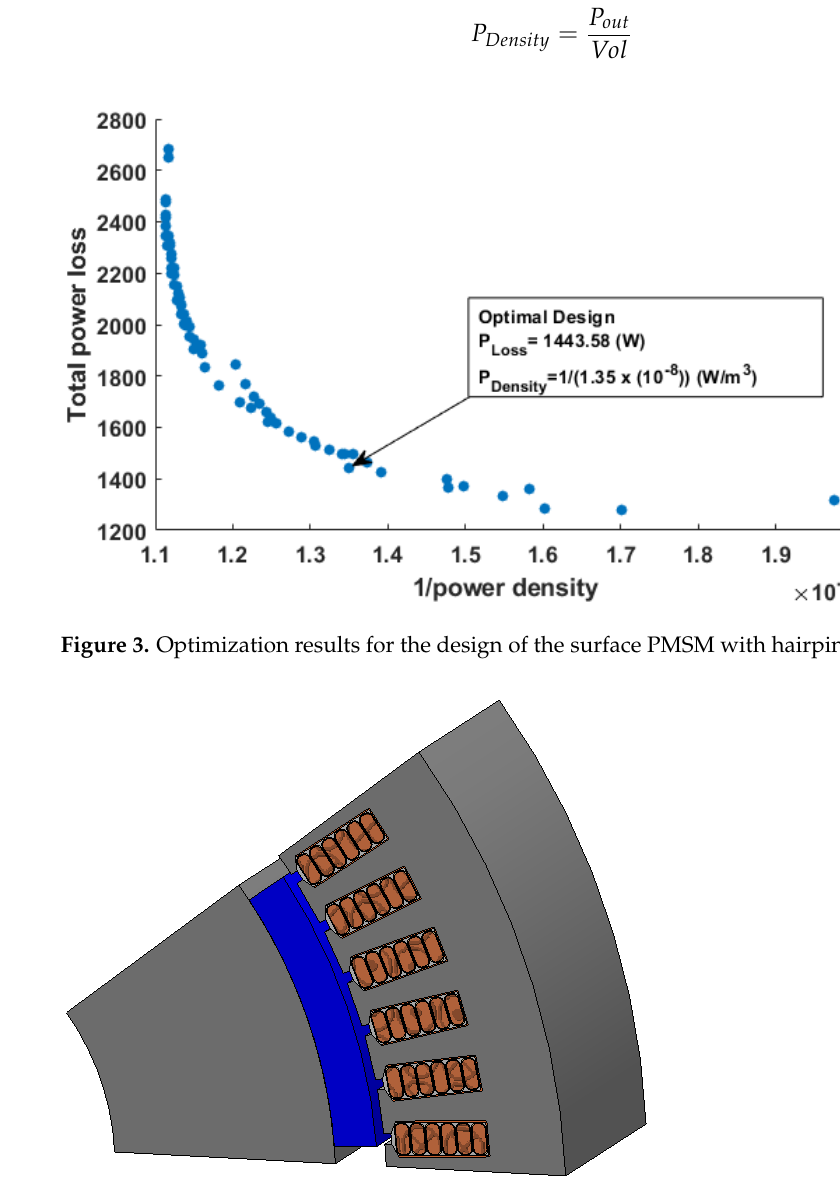
Figure 4. The geometry of the newly designed optimal motor.